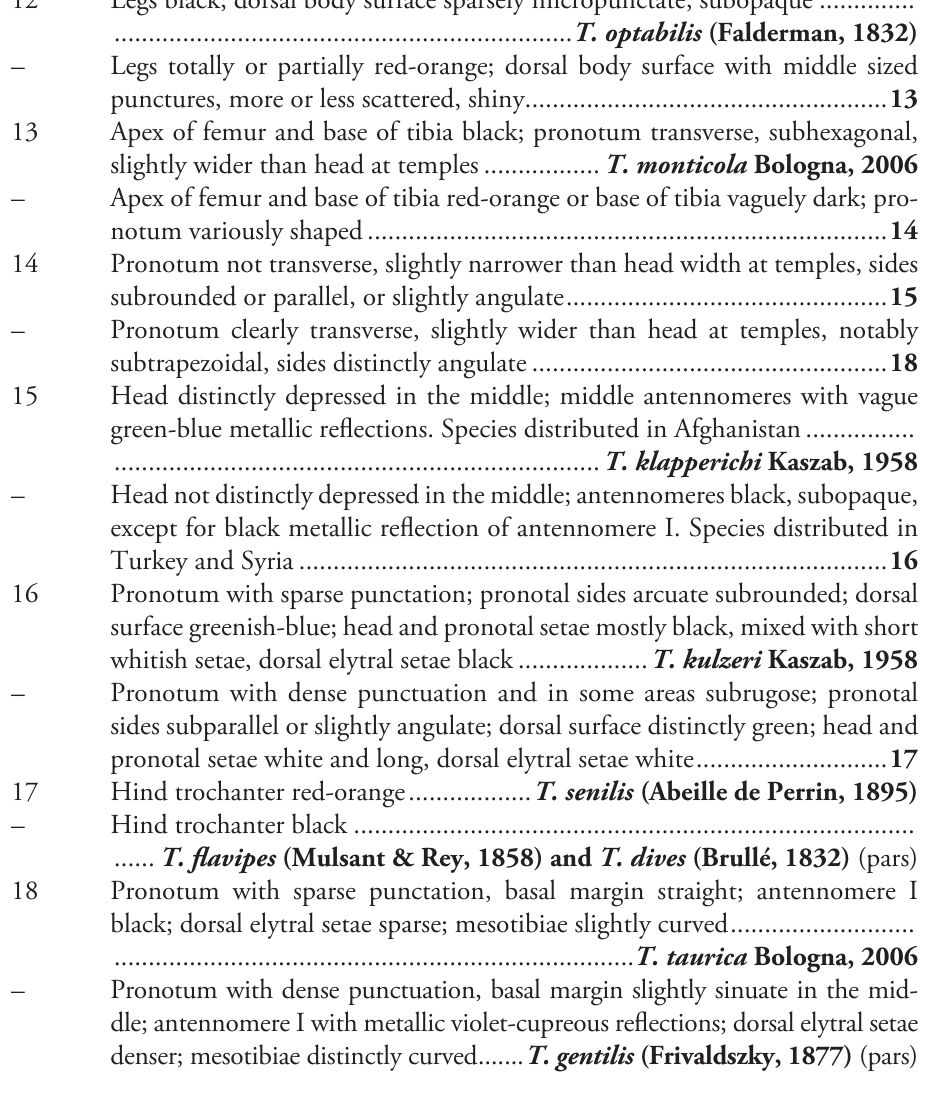
– Legs totally or partially red-orange; dorsal body surface with middle sized Apex of femur and base of tibia black; pronotum transverse, subhexagonal, – Apex of femur and base of tibia red-orange or base of tibia vaguely dark; pro- Pronotum not transverse, slightly narrower than head width at temples, sides – Pronotum clearly transverse, slightly wider than head at temples, notably Head distinctly depressed in the middle; middle antennomeres with vague